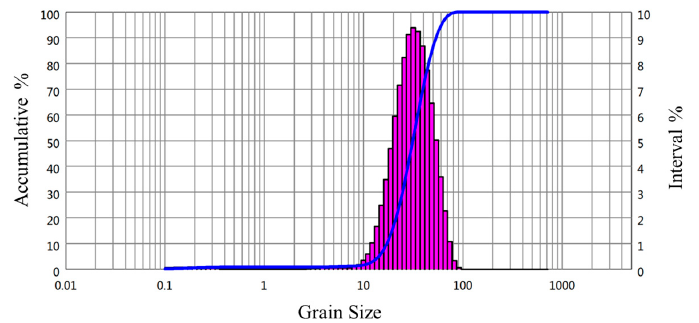
Figure 2. Particle size distribution of AlSi10Mg alloy powder.